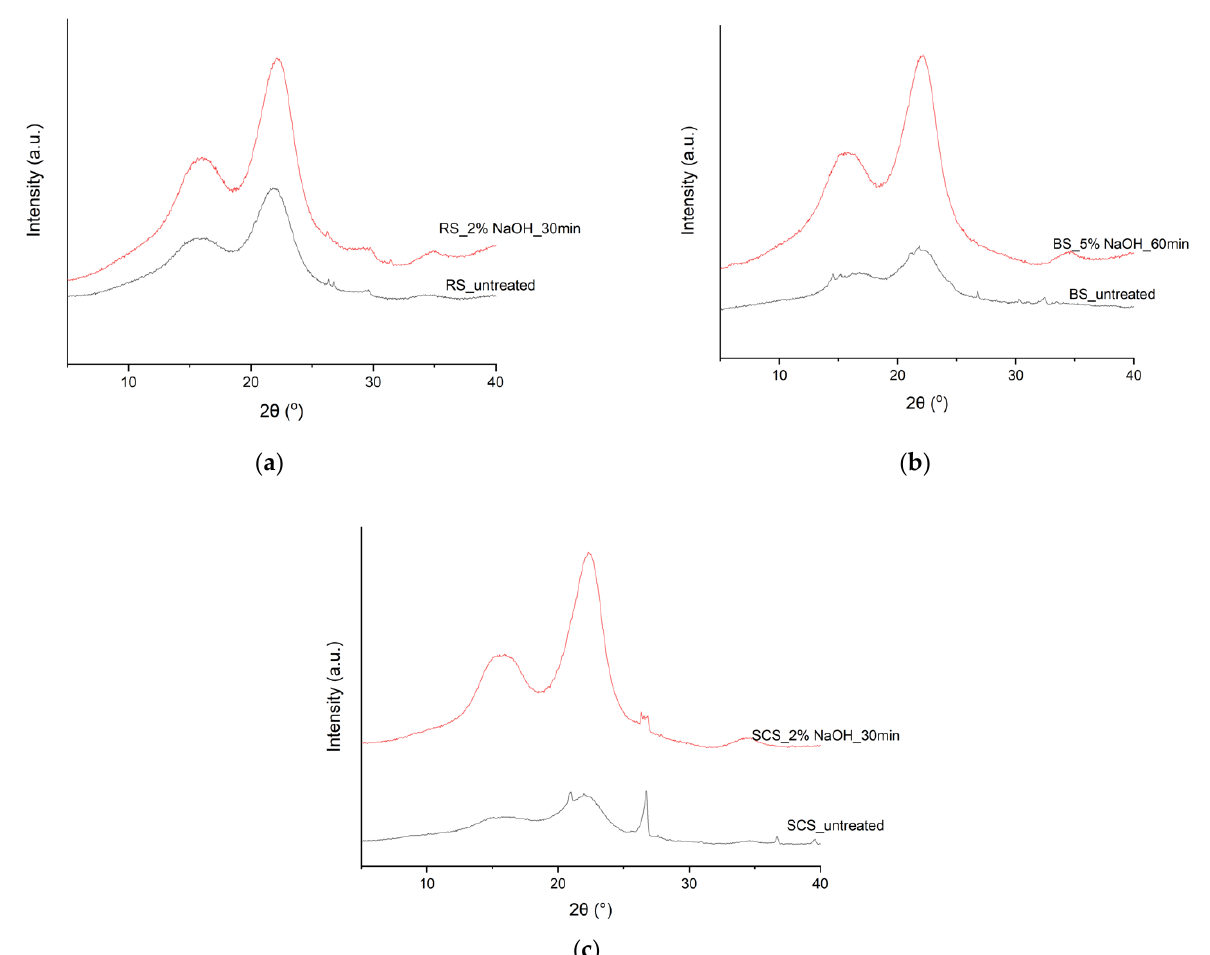
Figure 7. X-ray diffraction patterns of untreated and treated ( a ) RS, ( b ) BS, and ( c ) SCS fibers.